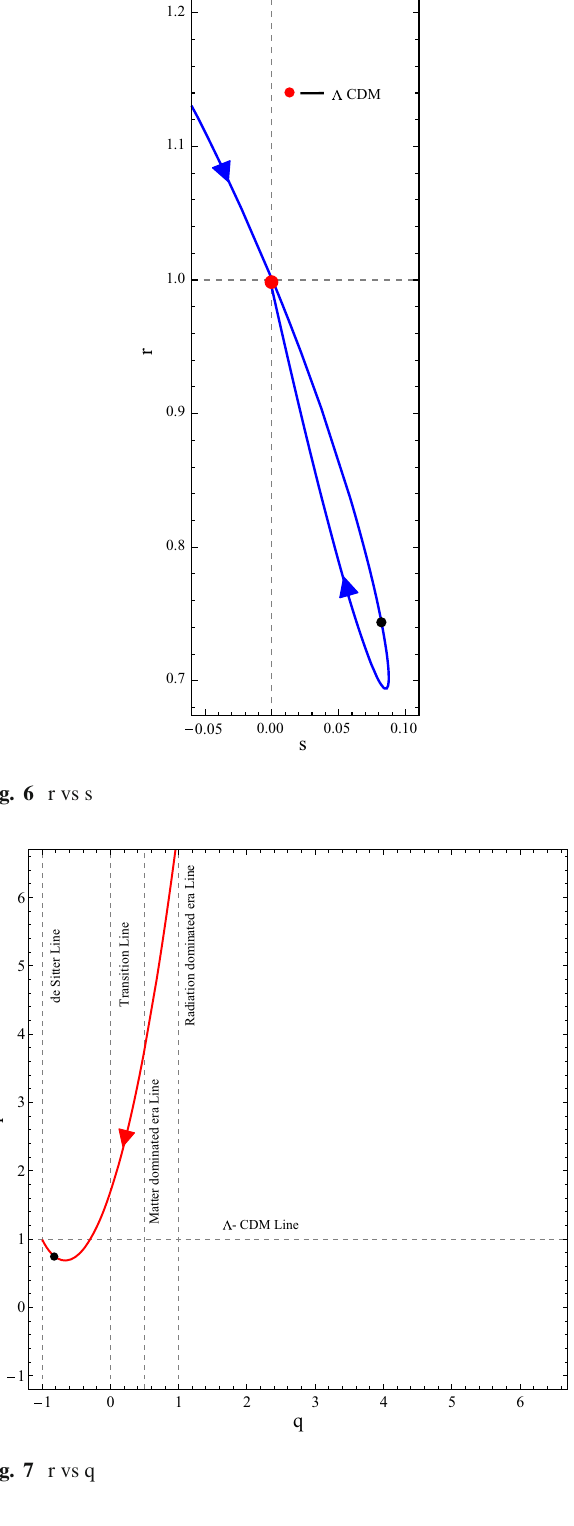
has impact. In the late phase the DE fluid has the dominance over bulk viscous fluid. From the evolutionary behaviour of the state finder pairs, we can infer that the model